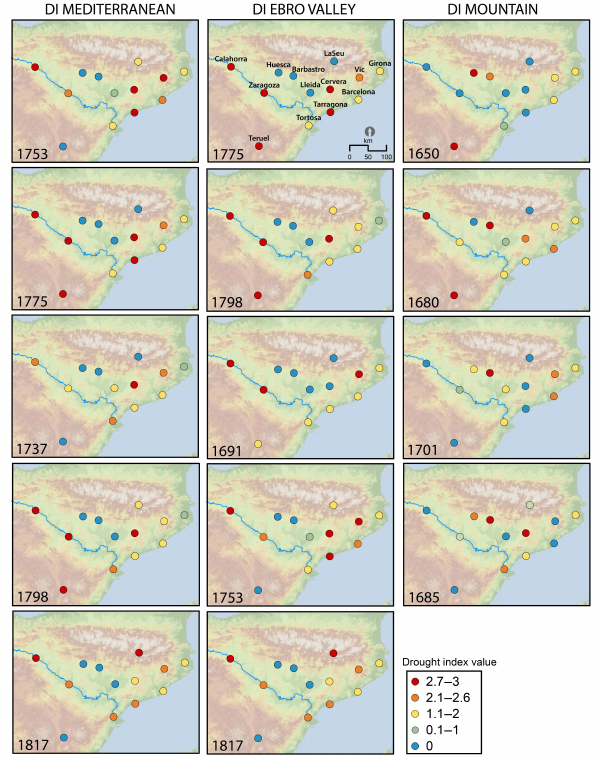
Figure 7. Spatial distribution of the most extreme drought years (based on the 99th percentile of the cluster drought indices). The distribution is given in a top-down order. The drought index value (magnitude) for each site within the cluster is also represented. The legend of the drought index value is based on the 30th, 60th, 70th, and 90th